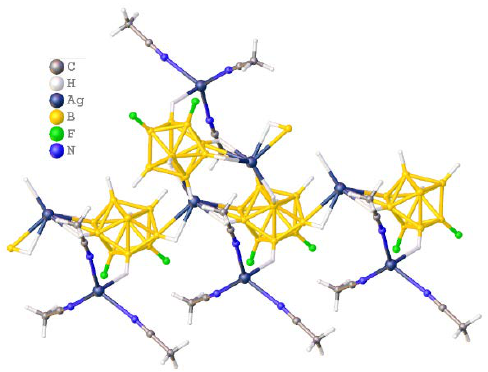
Figure 2. Structure of polymeric silver(I) complex [Ag(CH 3 CN) 3 ] 2 (Ag 2 [2-B 10 H 9 F] 2 ] n (F is disordered into two positions).